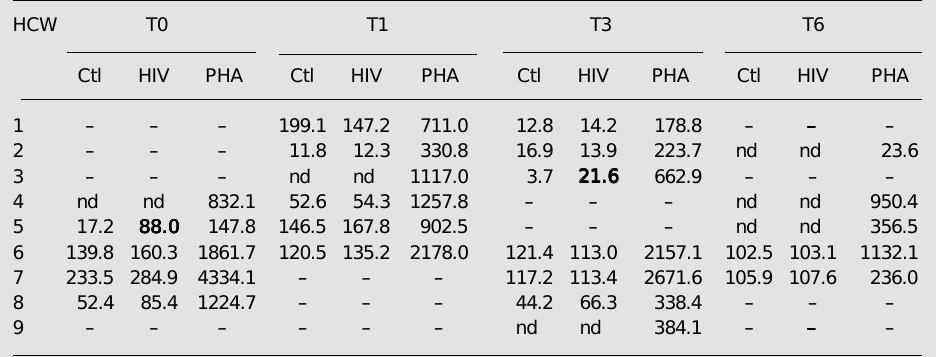
Table 2. Detection of IL-10 in supernatants of PBMC from health care workers (HCW) exposed to an HIV- negative source patient at the time of exposure and during